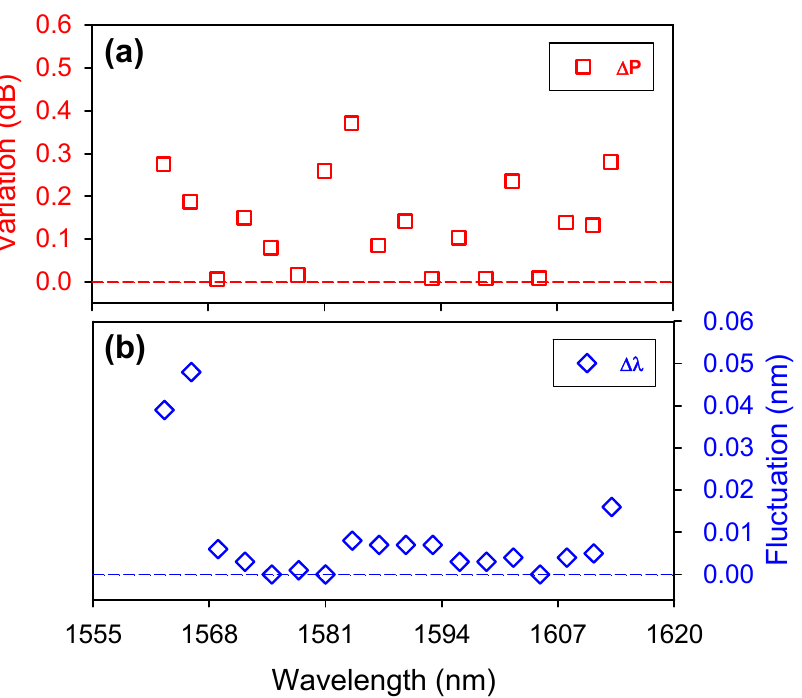
Figure 6. Measured largest fluctuations of ( a ) output power and ( b ) center wavelength in the whole tuning range of 1563.0 to 1613.0 nm.